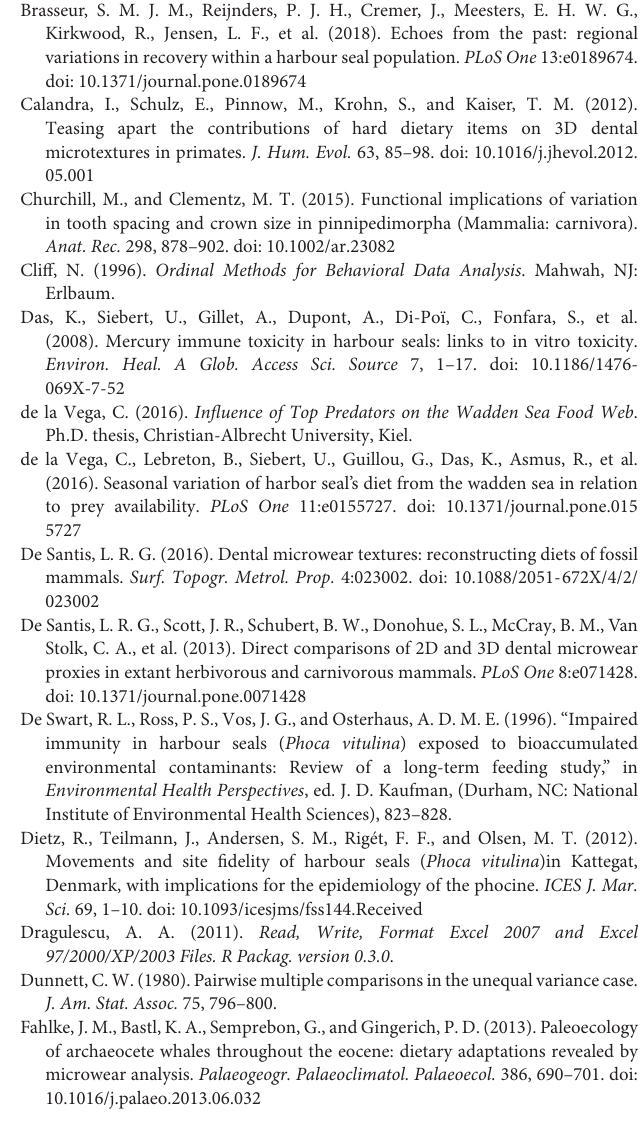
cusps marked by white arrows on PC2, PC3 and PC4 (from left to right). Calcified area on PC5 marked by black arrow. Scale = 1 cm. Supplementary Table 1 | Test statistics given for microwear texture data sorted. I3, third incisor teeth; C, canine teeth; PC2, second postcanine teeth; PC3, third postcanine teeth; PC4, fourth postcanine teeth; n, number of specimens; ST, surface texture parameter; Ft/ph, test statistics; p, level of significance (bold values indicate significant levels < 0.05); nu1/nu2/df, degree of freedom; pl, lower 95% confidence interval; pu, upper 95% confidence interval; pcrit, critical significance level α = 0.05; pcomp, 1 (p < pcrit) or 0 (p > pcrit). For descriptions of microwear texture parameter, see Table 2 . Supplementary Table 2 | Descriptive statistics (mean ± SD) for all DMTA parameters for the upper dentition of Phoca vitulina . For descriptions of microwear texture parameter, see Table 2 . Supplementary Table 3 | Overview table of the inter-individual variation within the tested groups and the given statistical significant microwear texture parameters. I3, third incisor teeth; C, canine teeth; PC2, second postcanine teeth; PC3, third